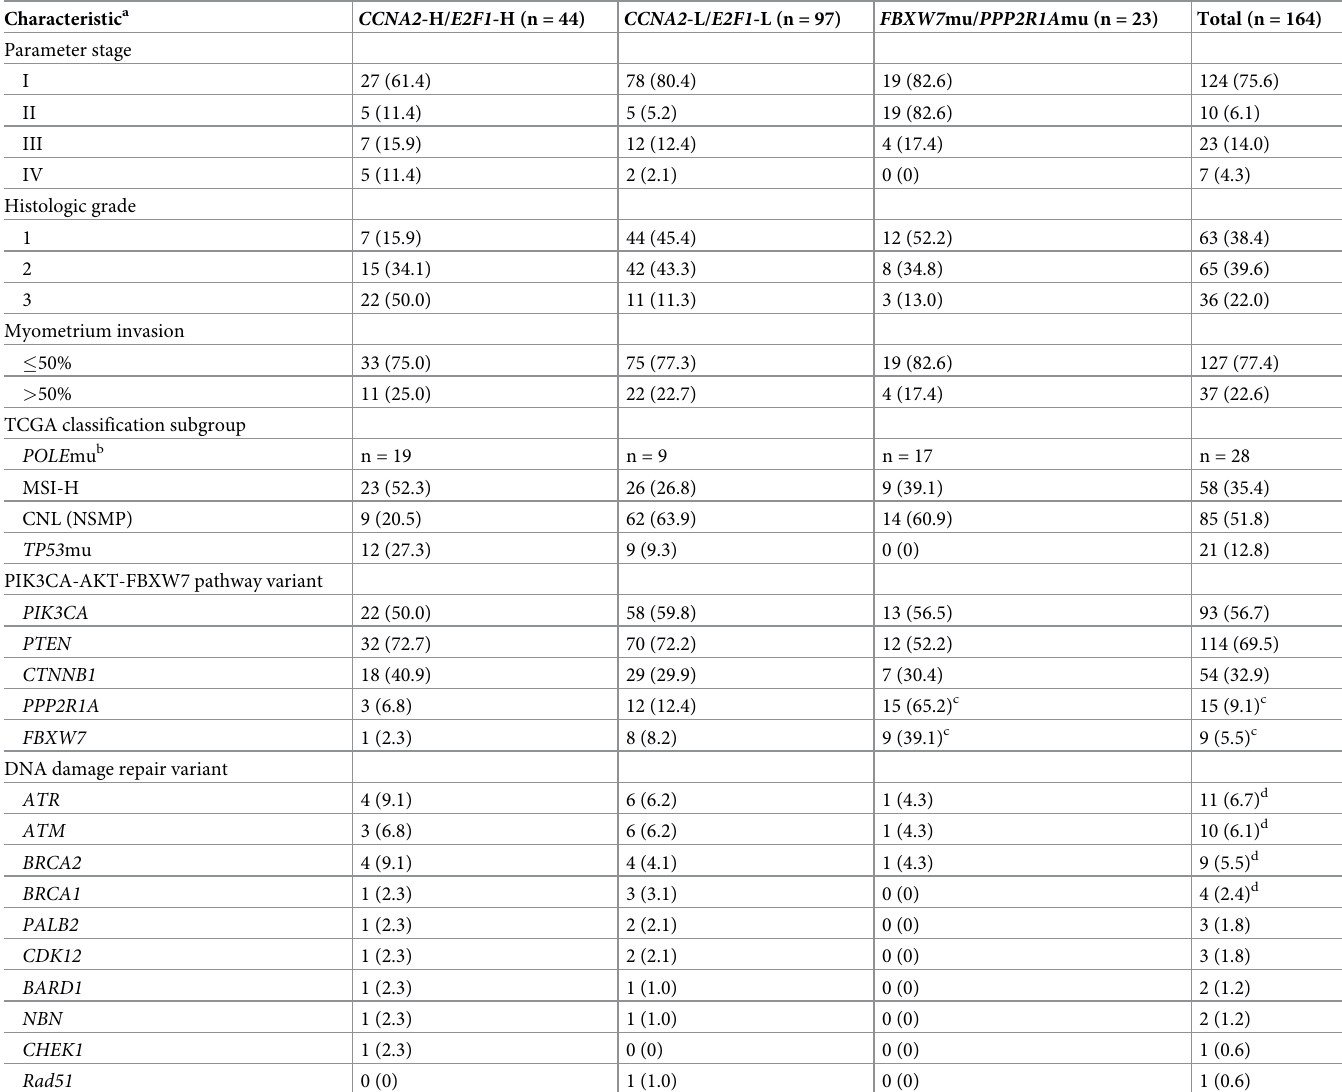
Table 1. Clinicopathologic parameters, TCGA subgroups, and select variants, stratified by molecular high-risk and low-risk endometrioid endometrial cancer. Characteristic